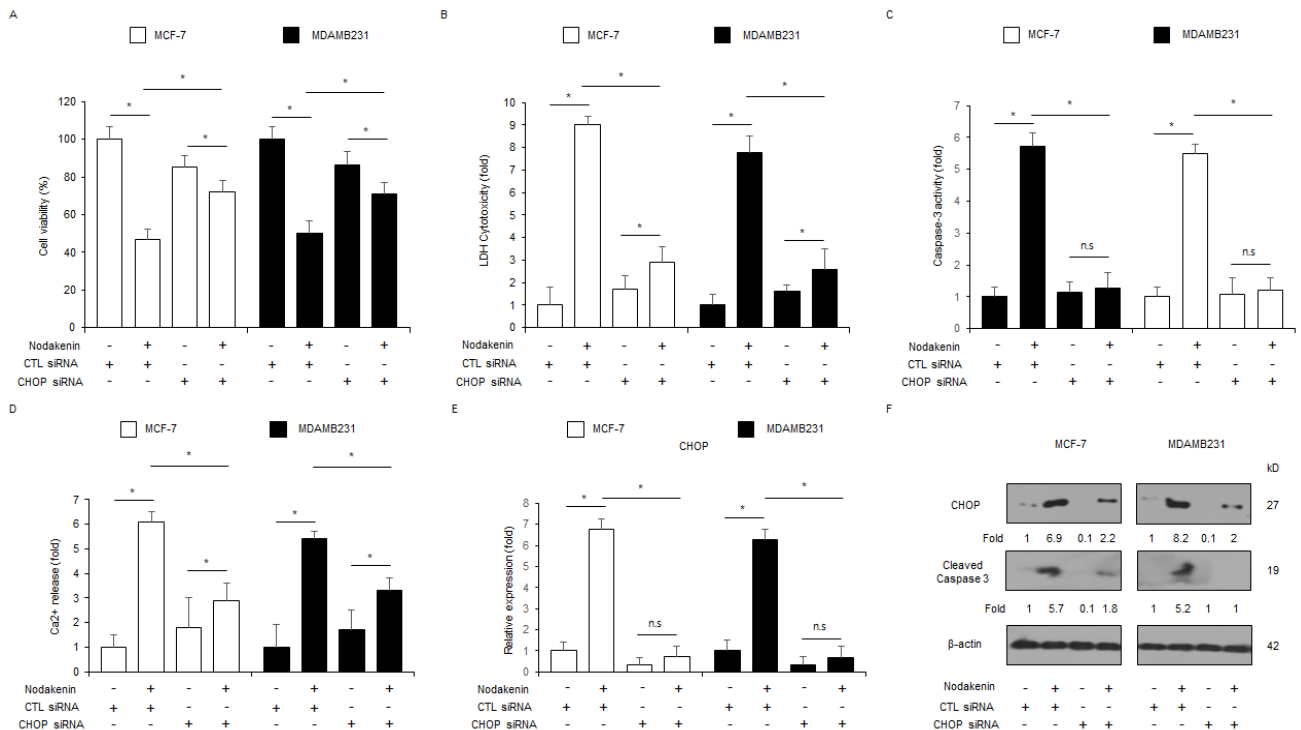
Figure 6. Inhibition of CHOP suppresses nodakenin-mediated apoptosis and cell death in breast cancer. ( A – D ) MCF-7 and MDAMB231 cells were transfected with CHOP siRNA with nodakenin (40 μM, 24 h) treatment, and LDH cytotoxicity, WST-1, caspase-3 activity, and Ca 2+ assays were carried out; * p < 0.05. n.s., not significant. ( E , F ) Real-time qRT-PCR for CHOP expression levels and Western blot analyses for CHOP and caspase-3 cleavage levels in nodakenin (40 μM, 24 h)-treated MCF-7 and MDAMB231 cells with CHOP siRNA (30 nM, 24 h). β -actin was used as the mRNA and protein-loading controls. Western blot analyses and real-time RT-PCR were confirmed in at least three independent experiments.